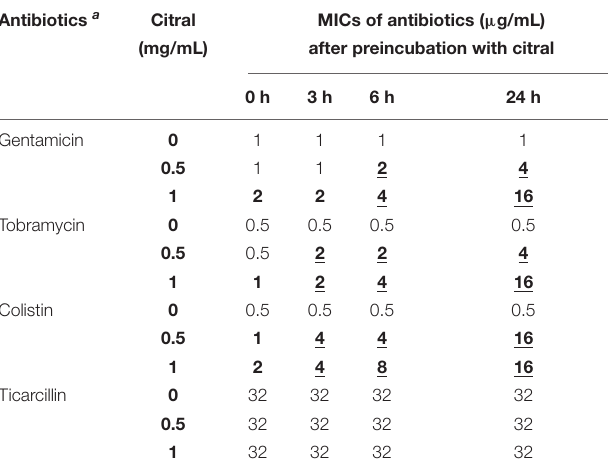
TABLE 2 | Preincubation with citral reduces the activity of aminoglycosides and colistin on P. aeruginosa strain PA14. Antibiotics a Citral MICs of antibiotics ( µ g/mL)